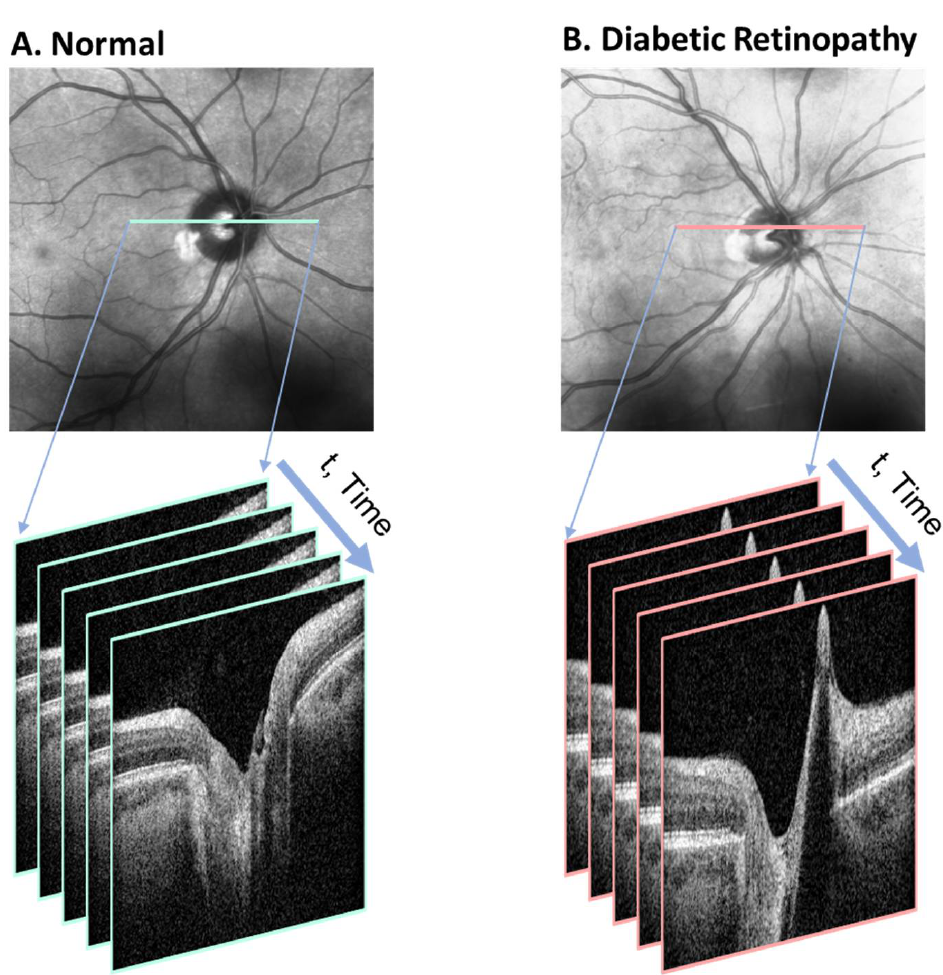
Figure 1. The en face view and sequential OCT B-scans of the posterior eye in ( A ) a normal subject and ( B ) a patient with diabetic retinopathy.